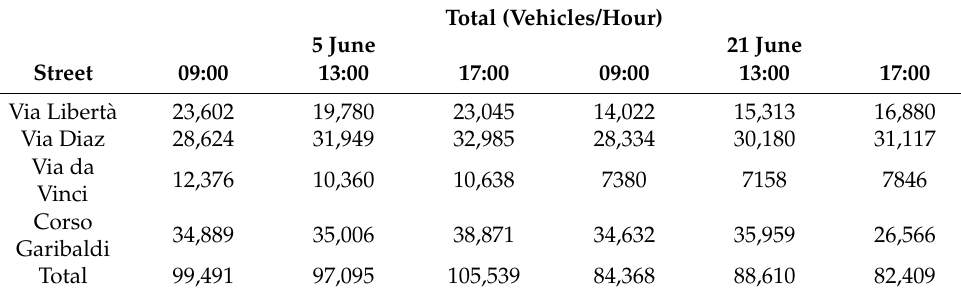
Table 2. Overview of traffic vehicular campaigns.